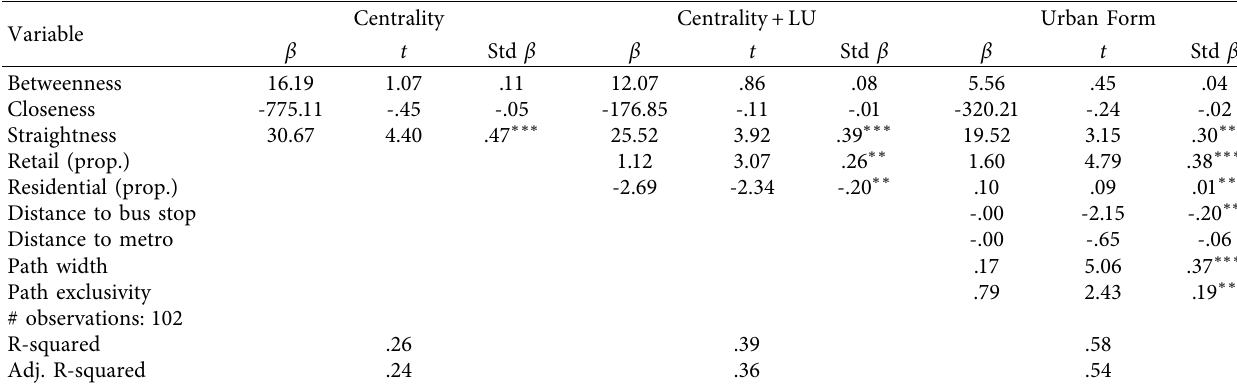
Table 6: Osaka-Namba: multivariate regression results.